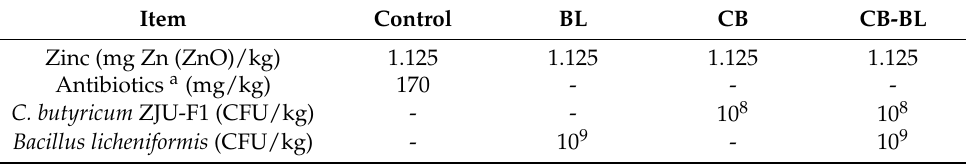
Table 1. Dietary supplementation of 4 different treatments based on the basal diet. Item Control BL